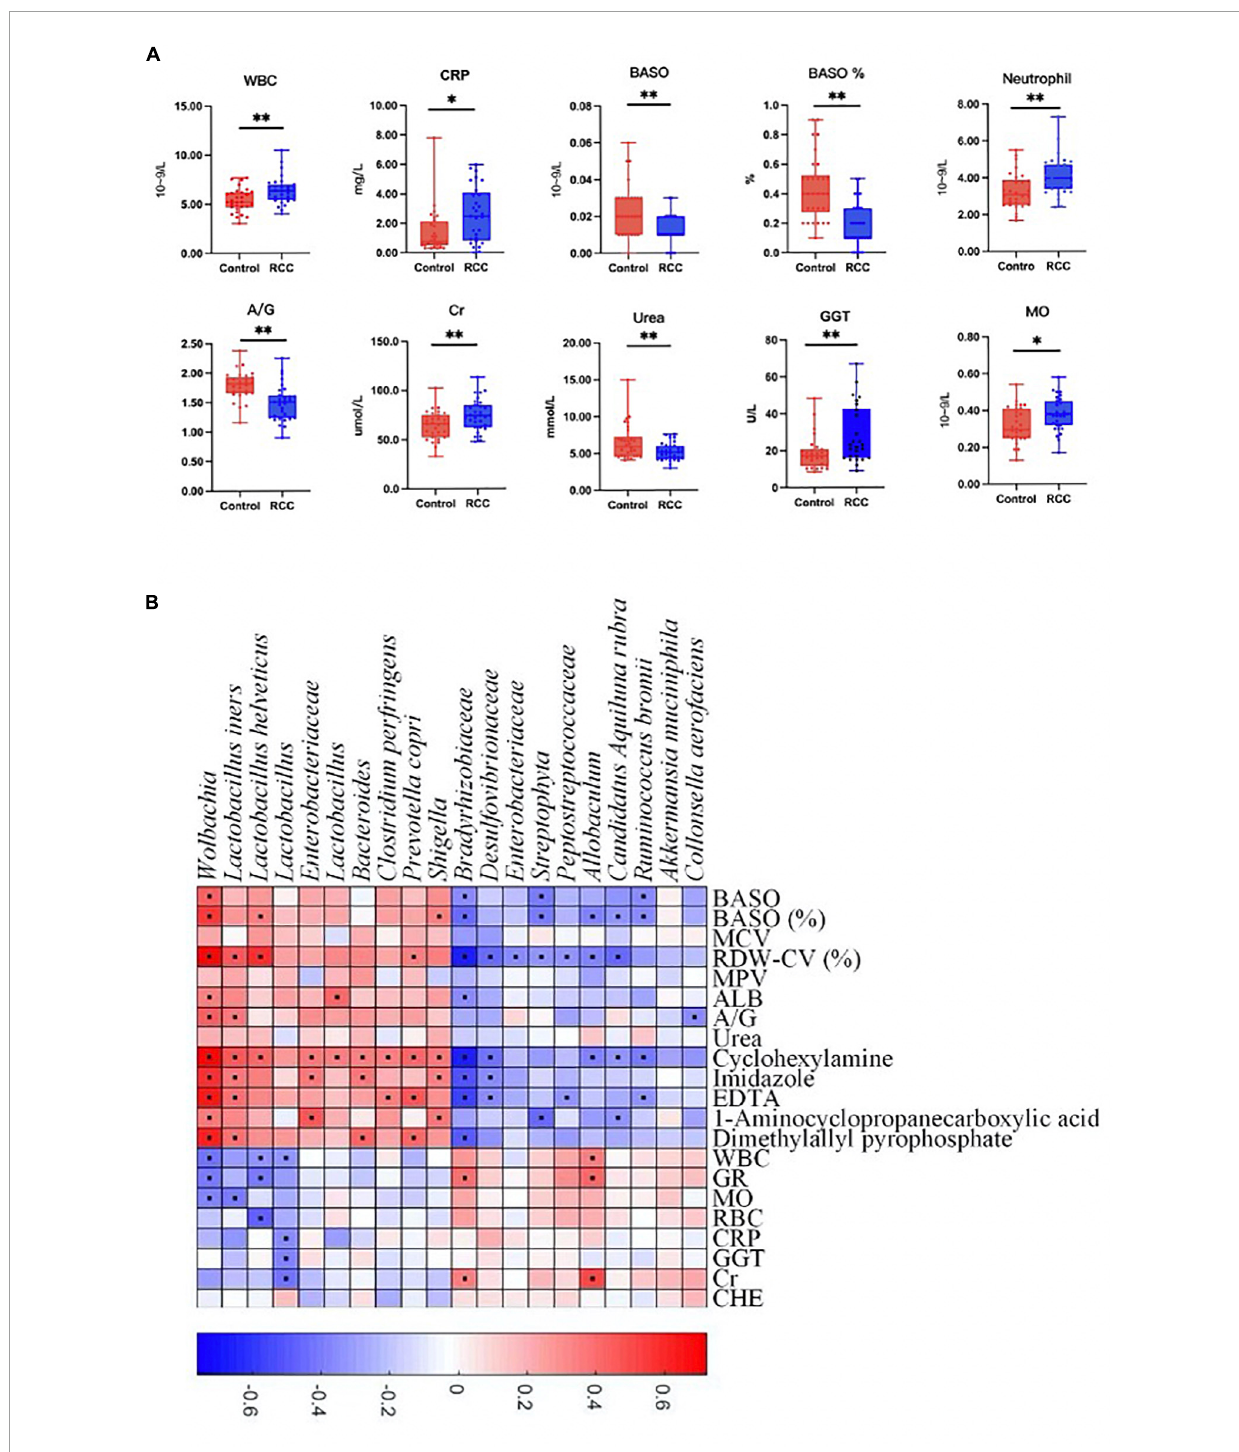
FIGURE3 Association between altered gut microbiota and clinical indices. (A) The differential levels of clinical indices were selectively detected between the RCC group and the Control group. (B) Correlation between altered genera and clinical indices of ccRCC patients. Red and blue color denoted positive and negative correlations, respectively. The black dots in the cells of the heatmap indicated the correlations were significant. WBC, white blood cell; CRP, C-reactive protein; BASO, basophil; A/G, albumin/globulin; Cr, creatinine; GGT, γ -glutamyl transpeptidase; MO, monocytes. ∗ P < 0.05, ∗∗ P <